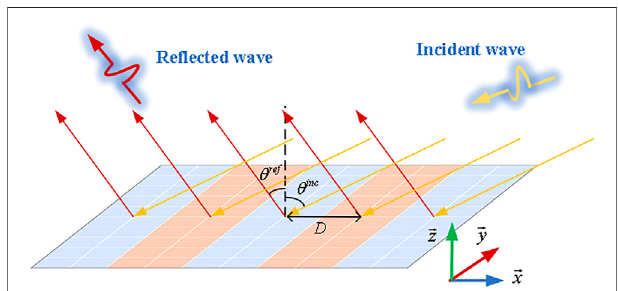
FIGURE 5 | Schematic diagram of the relationship between the incident wave and re fl ected wave based on the geometrical-optical approximation method.